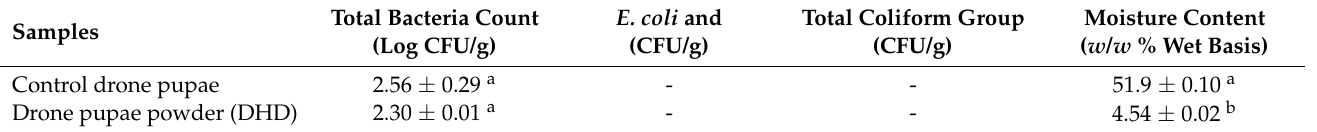
Table 6. The microbial qualities and moisture content of the control drone pupae and optimal drone pupae